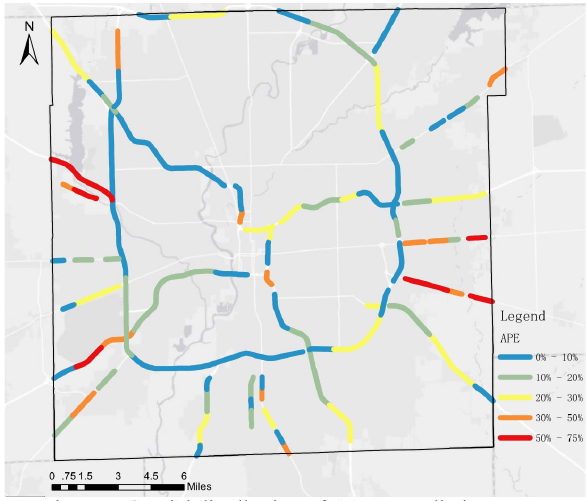
Figure 7. Spatial distribution of AADT prediction